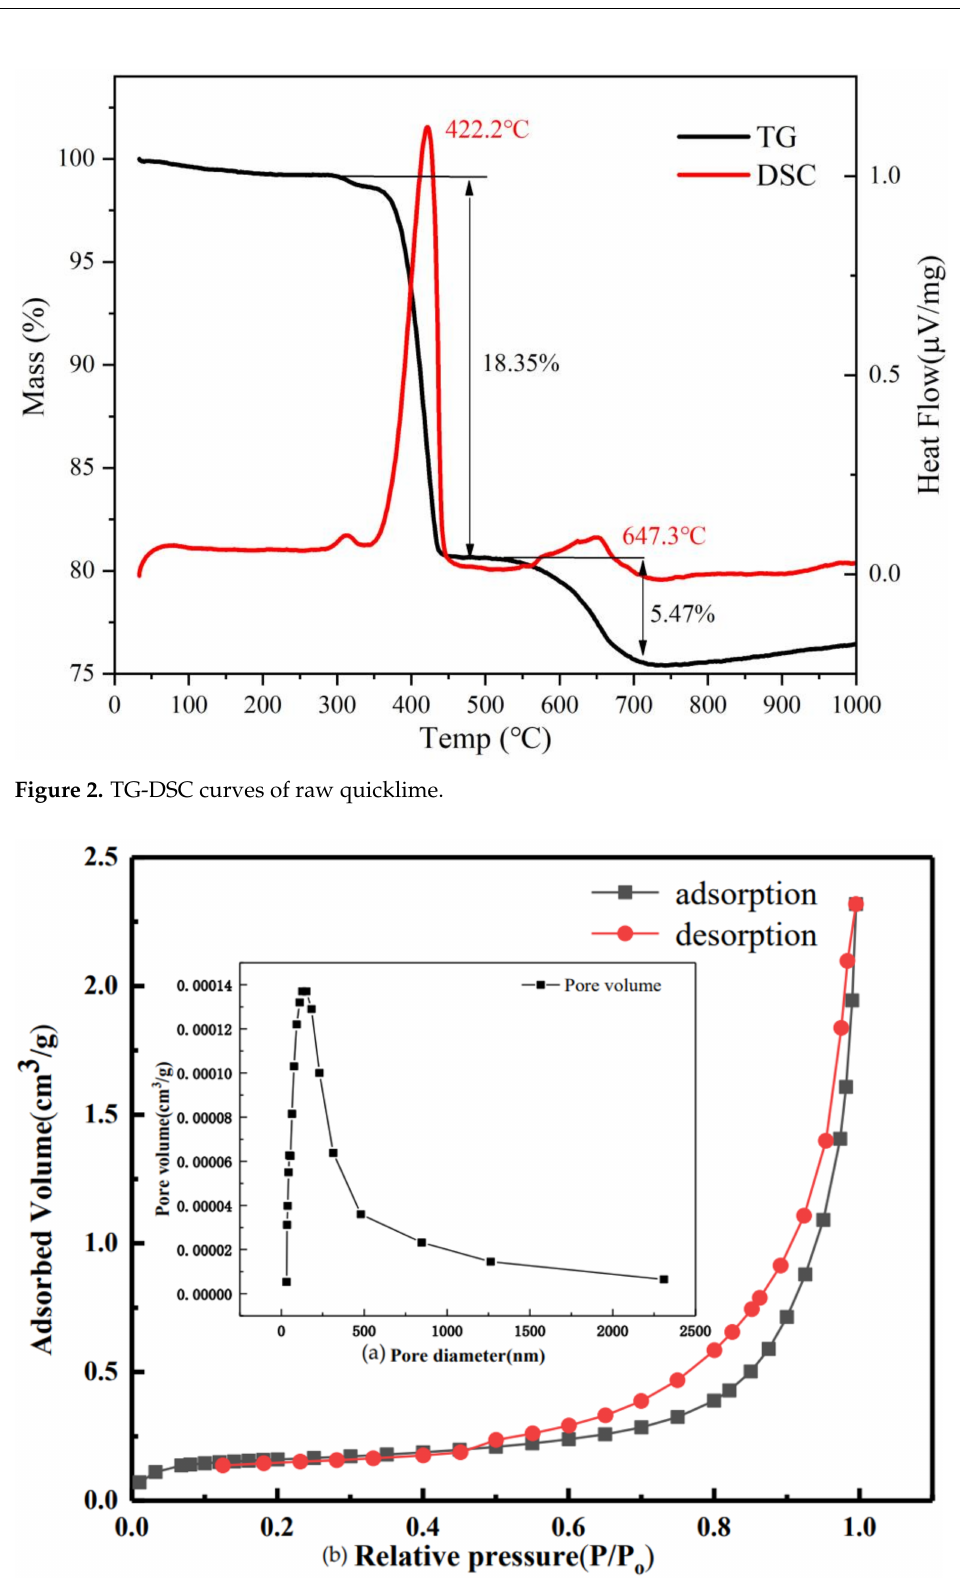
Figure 3. Isothermal adsorption and desorption curves ( a ) and pore size distribution curve ( b ) of